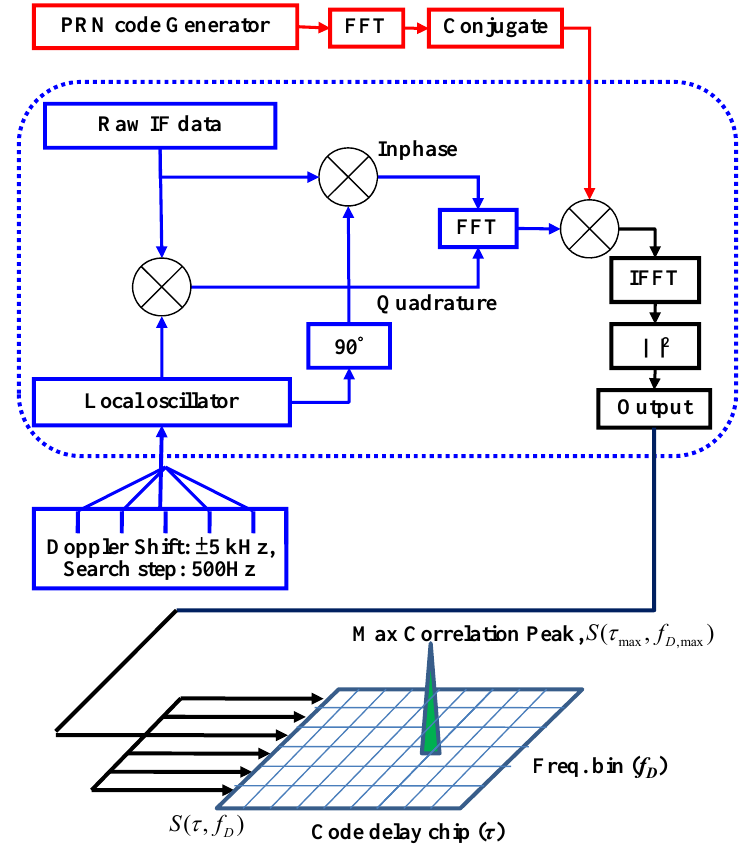
Figure 3. The GPS signal acquisition process using the parallel code phase search acquisition